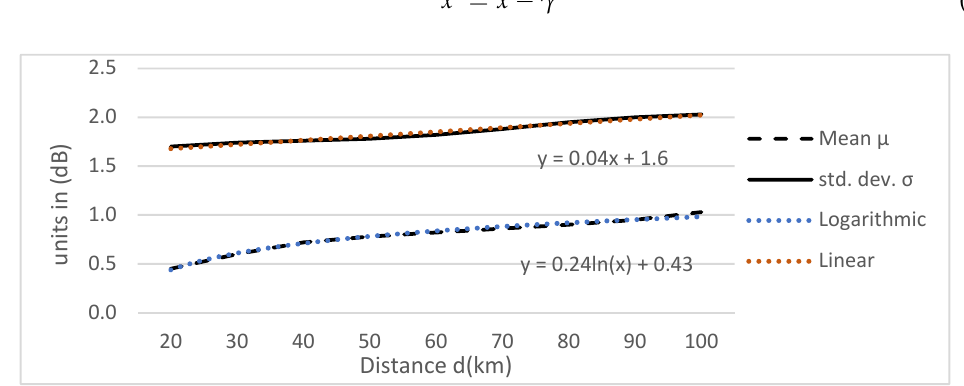
Figure 5. Trendline equations for 𝜇 and 𝜎 parameters with varying distance up to 100 km.